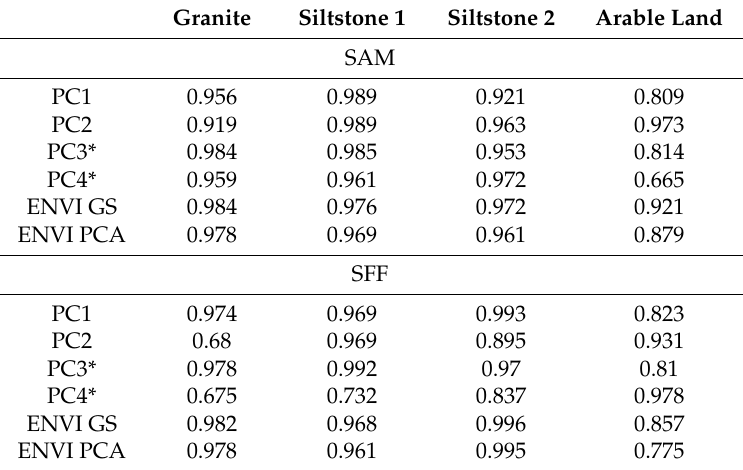
Table 11. SAM and SFF scores achieved when comparing the Landsat 8 reference and the fused image spectrum. The higher the score the higher the match (0: no match, 1: identical spectrum). It was expected that the first two PCs have the potential to give good results when employing the PCA sharpening process, however PC3* and PC4* were used to compare the result and explain it in a wider context.